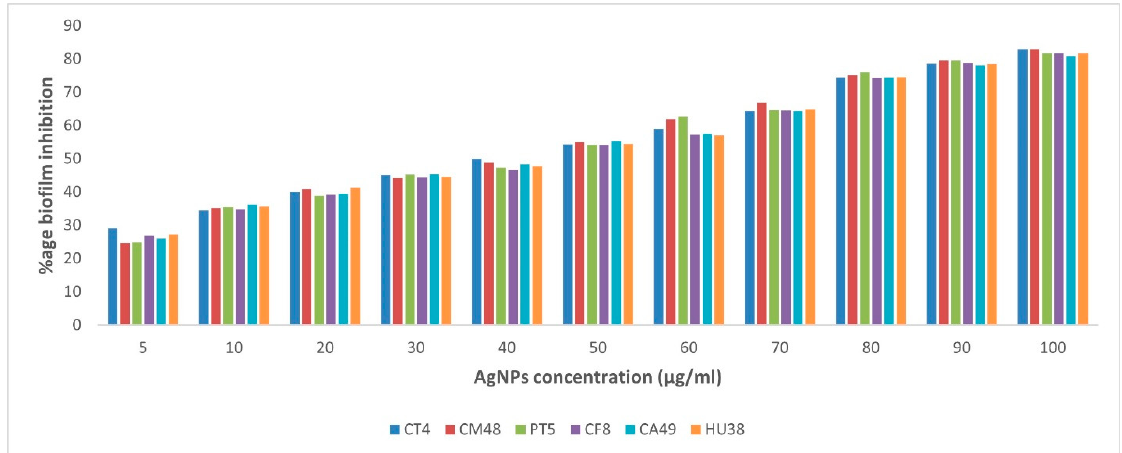
Figure 3. Percent inhibition of biofilm formation by various concentrations of AgNPs against Clostridium perfringens . The absorbance was measured at 620 nm for the quantification of biofilm formation. CT: chicken intestine, CM: chicken meat, PT: pigeon intestine, CF: camel feces, CA: camel meat, HU: human stool. Table 4. Qualitative estimation of color intensity of biofilm formation by tube method in absence and presence of silver nanoparticles (AgNPs) at different concentrations on Clostridium perfringens isolates.